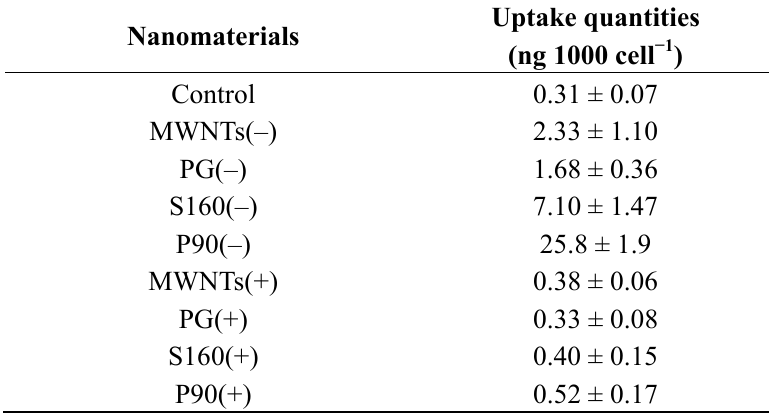
Table 2. Cellular uptake of 125 I labeled phenol red in cell culture medium with or without serum. The concentration of CNPs in all samples was 100 µg mL − 1 , (–: CNPs dispersed in serum-free medium; +: CNPs dispersed in complete medium). All data shown are the mean values of three experiments ±